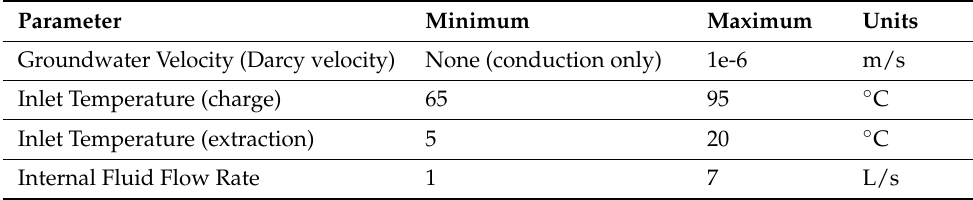
Table 2. Parameters tested in this